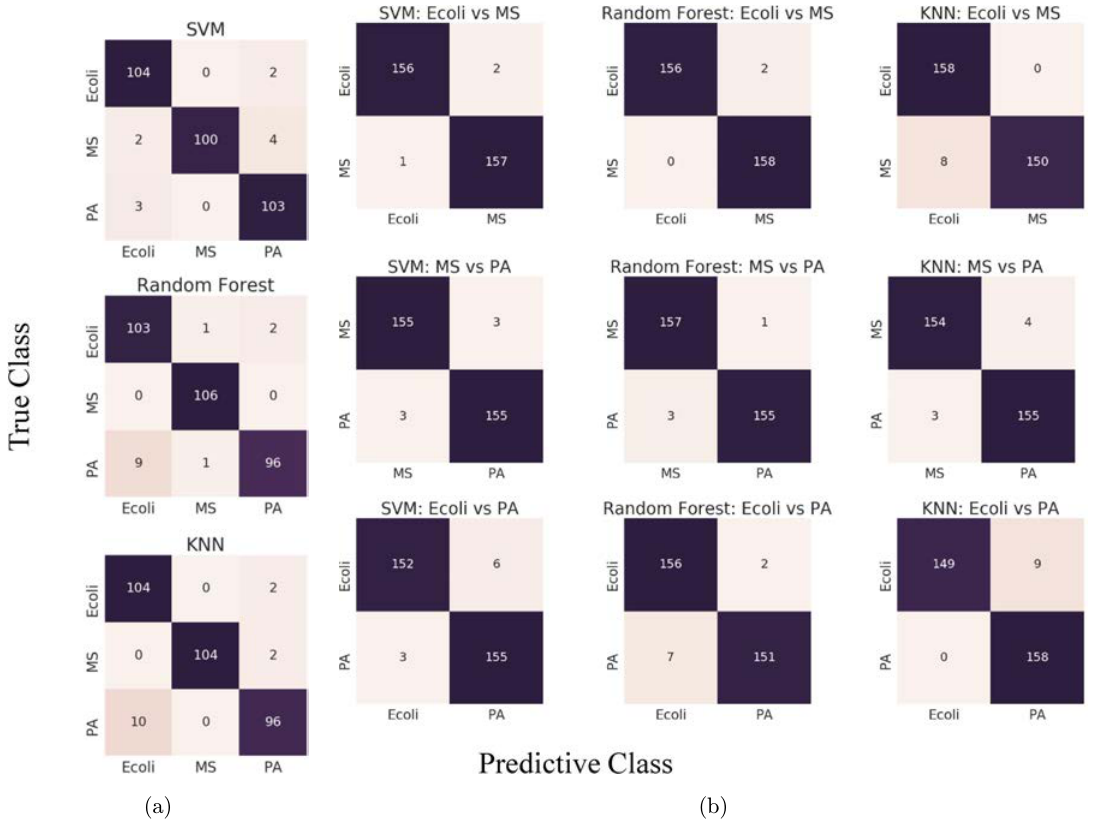
Fig. 6. The representative confusion matrices (e.g., in SVM confusion matrix, of the 106 actual E. coli , the classi¯er predicted that two were PA, and of the 106 MS, it predicted that two were E. coli and three were PA). (a) Confusion matrices for the classi¯ers in the multi-classi¯cation test. (b) Confusion matrices in the binary-classi¯cation test. E. coli is an abbreviation for E. coli , MS is for Mycobacterium smegmatis and PA is for Pseudomonas aeruginosa .